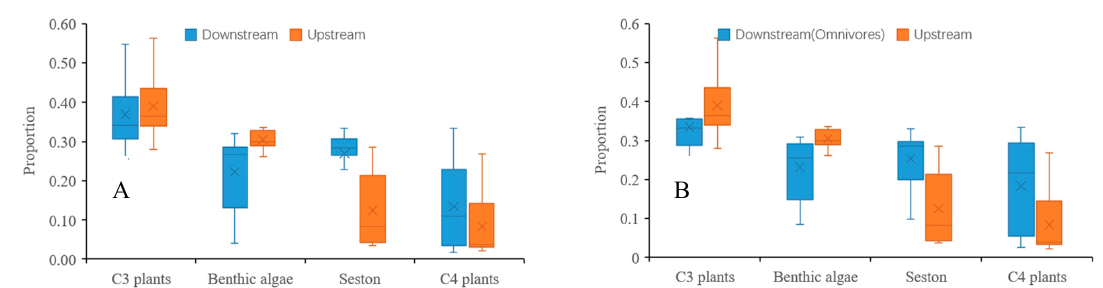
Figure 4. Comparison of the highest likely contributions of four basal carbon sources to fish species between the downstream (backwater zone) and the upstream. ( A ) All fish species from the downstream and upstream; ( B ) only omnivorous fish from the downstream and all of the upstream fish. Boxes show the interquartile range, and whiskers show the 10th and 90th percentiles. The median and mean values are shown as a horizontal line and cross in the middle of the box, respectively.